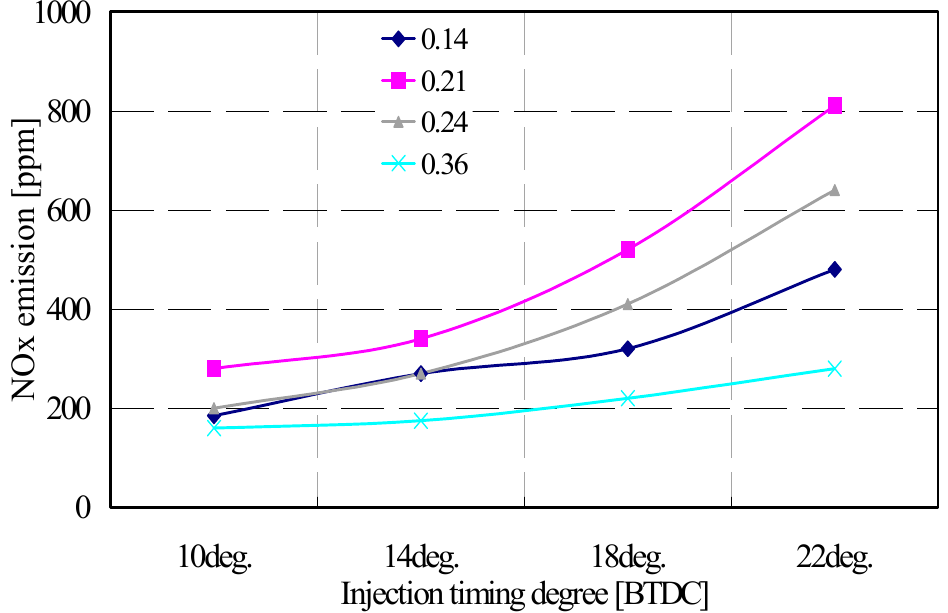
Figure 15. NO x emission characteristics of DME engines with nozzle needle lift as a function of injection timing degree.